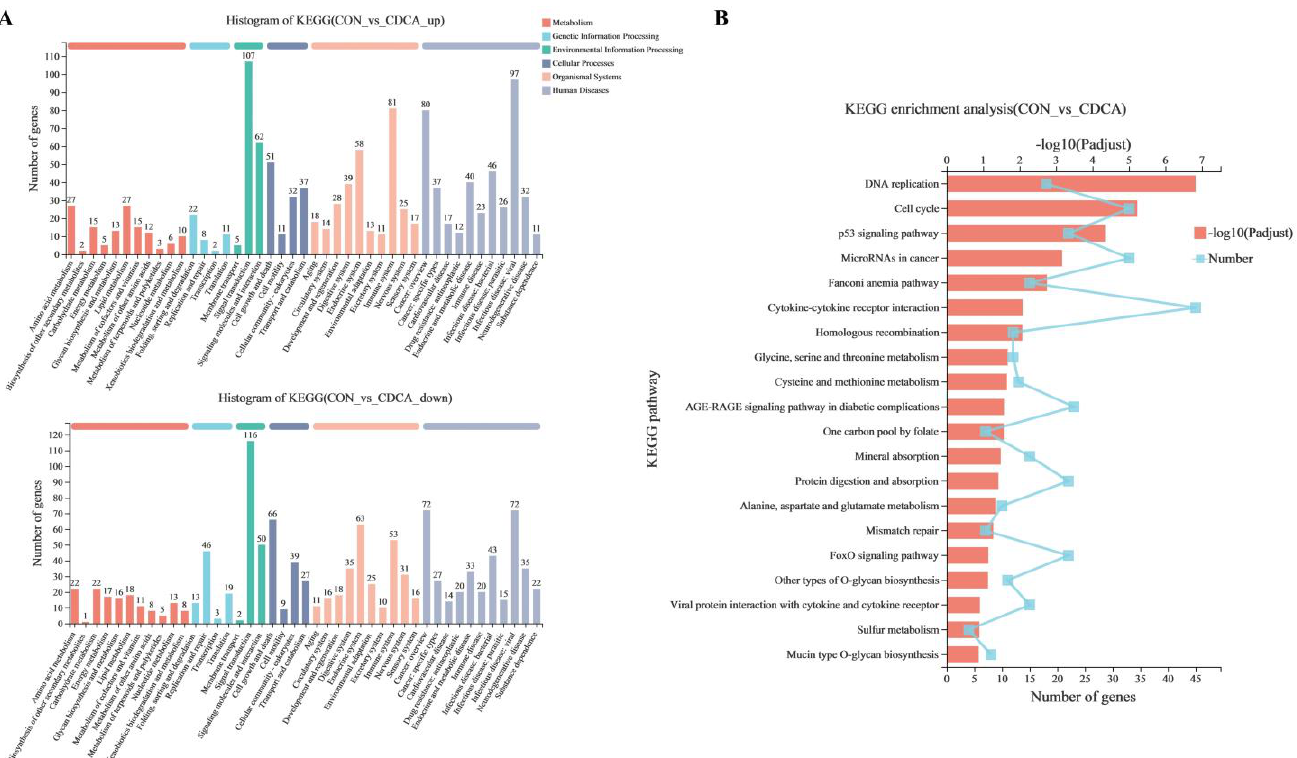
Figure 7. Effects of CDCA on KEGG functional annotation and enrichment analysis of IPEC-J2 cells. Histogram of KEGG functional annotation results for CON and CDCA groups ( A ). Scatter plot of KEGG enrichment results for CON and CDCA groups ( B ). KEGG, Kyoto Encyclopedia of Genes and Genomes.